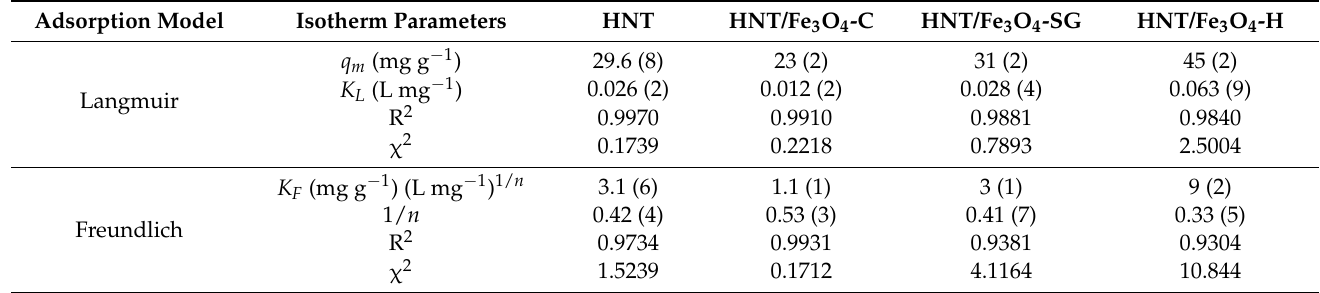
Table 4. Isotherm parameters for OFL adsorption onto HNT, HNT/Fe 3 O 4 -C, HNT/Fe 3 O 4 -H, and HNT/Fe 3 O 4